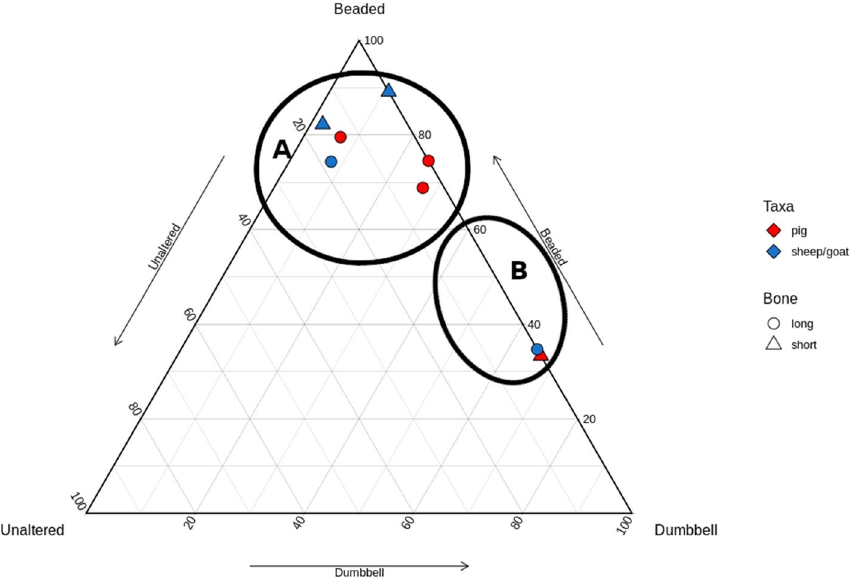
Figure 6. Ternary plot of Potterne samples; two natural groups are